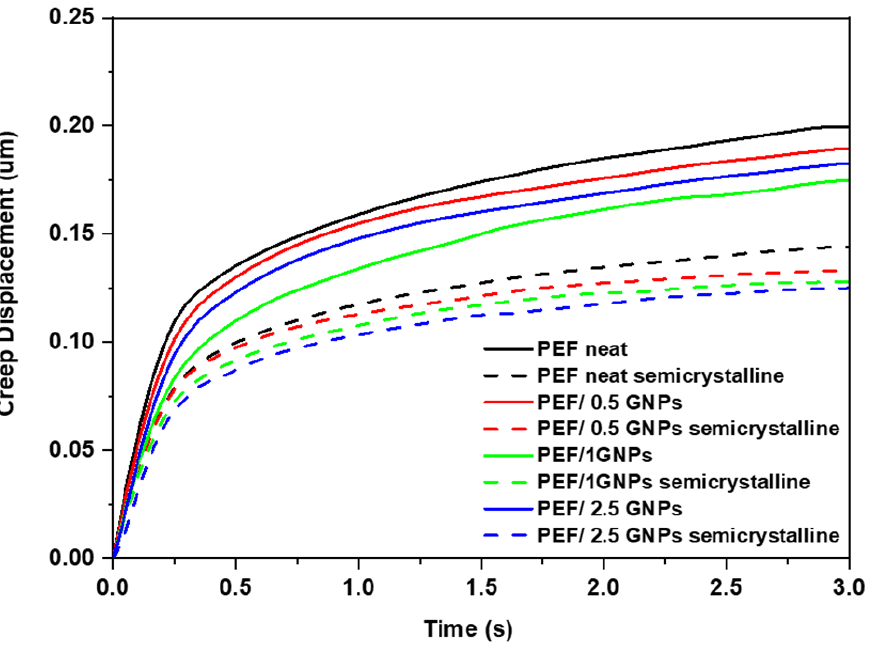
Figure 12. Comparison of representative creep displacement–time curves of the amorphous and semicrystalline neat PEF and PEF/GNP nanocomposites.